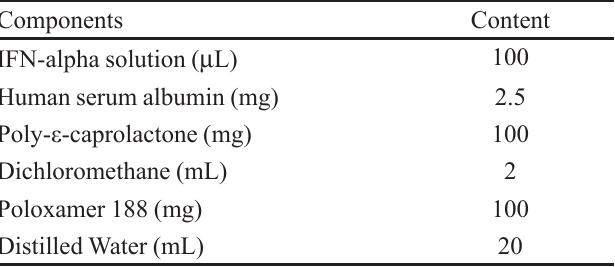
TABLE I - Composition of the developed microsphere